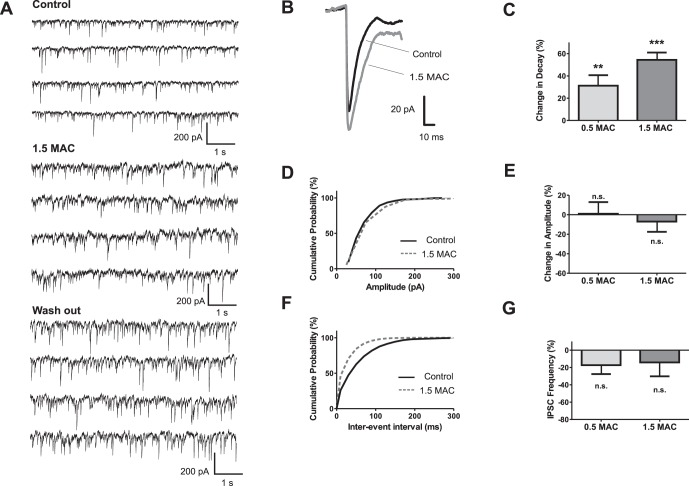
Glycinergic IPSC frequency remained stable at a high sevoflurane concentration.(A) Representative traces of glycine receptor-mediated IPSCs for control condition (upper trace), sevoflurane application (middle trace) and wash out (lower trace). Glycine IPSCs were isolated by adding CNQX (50 µM), AP5 (50 µM), and bicuculline (100 µM). (B) Overlay of the averaged IPSCs from the presented experiment in (A). (C) Summary of analyzed experiments revealed that sevoflurane significantly increased the IPSC decay time by 31.2±9.4% at 0.5 MAC (n = 6, p<0.01), and by 54.4±7.6% at 1.5 MAC (n = 12, p<0.001). Absolute decay time values were 8.02±0.52 ms for control (n = 18), 10.78±0.81 ms for 0.5 MAC (n = 6), and 11.82±0.87 ms for 1.5 MAC sevoflurane (n = 12). (D) Cumulative distribution of IPSC amplitudes from the representative experiment depicts that sevoflurane slightly shifted the population to higher amplitudes. (E) Pooled data showed that the mean of IPSC amplitudes was basically not changed under sevoflurane (change in amplitude 1.04±11.91% for 0.5 MAC, n = 6, and −7.01±10.46% for 1.5 MAC, n = 12). (F) In the presented experiment, sevoflurane reduced the inter-event intervals as shown by the cumulative distribution plot. (G) Data from all experiments revealed that sevoflurane did not significantly affect IPSC frequency at both concentrations (change in frequency −17.3±10.3% (n = 6) for 0.5 MAC, and −14.2±16.0% (n = 10) for 1.5 MAC). **p<0.01, and ***p<0.001 as indicated.